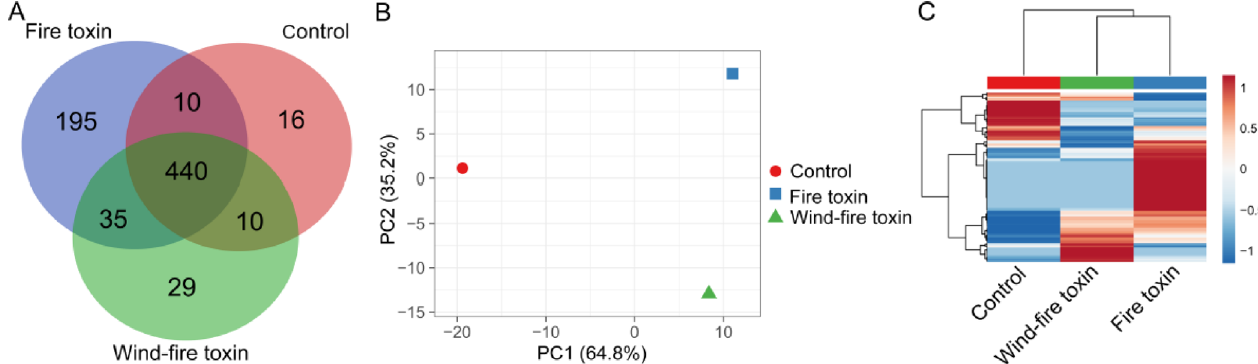
Figure 1. An overview of the distribution of the serum protein expression profiles. (A) A Venn diagram of the snakebite proteins in the wind-fire toxin and fire toxin groups and the healthy control group. (B) Principal component analysis accounted for 64.8% of the observed variation between the snakebite groups and the healthy control group at the first principal component (PC1), as well as 35.2% of variability between the wind-fire toxin and fire toxin groups at PC2. (C) The clustering of serum proteins revealed distinct protein expression patterns in the wind-fire toxin and fire toxin groups and the healthy control